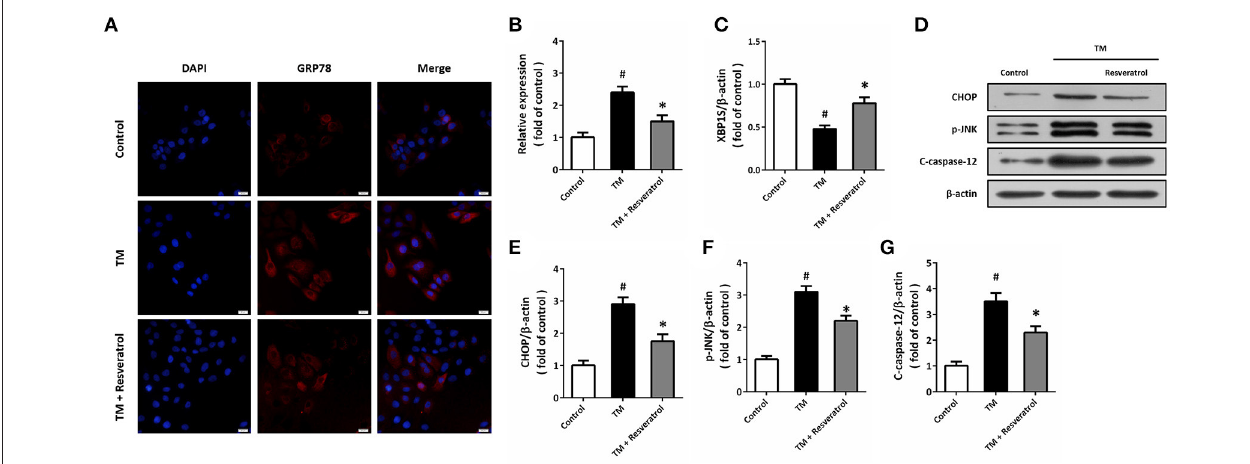
FIGURE 2 | Resveratrol attenuates TM-induced ER stress in HT22 cells. HT22 cells were treated with 100ng/ml TM with or without 50 µ M resveratrol for 24h. The expression of GRP78 protein was detected by immunofluorescence staining (A) and calculated (B) . The mRNA levels of XBP1S was examined by RT-PCR (C) . The expression of CHOP, p-JNK and cleaved-caspase-12 was detected by western blot (D–G) . Data are shown as mean ± SEM. # p < 0.05 vs. Control. * p < 0.05 vs. TM. Scale bar = 20 µ m.